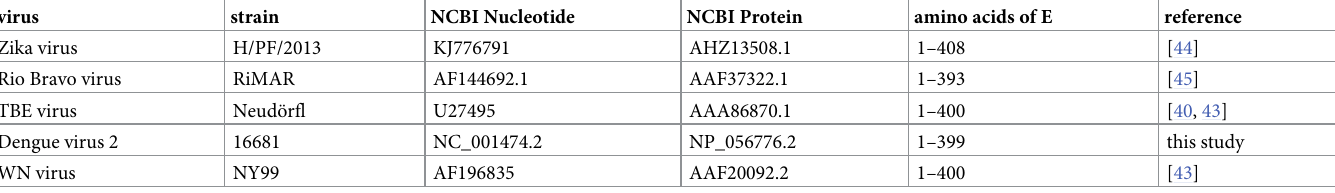
Table 1. Recombinant soluble E proteins a